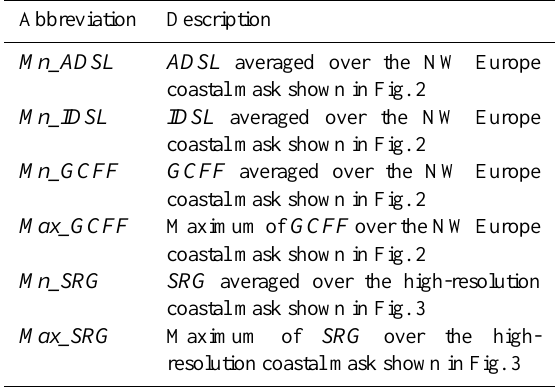
Table 2. Definitions and abbreviations used for those components which are evaluated on a local coastal